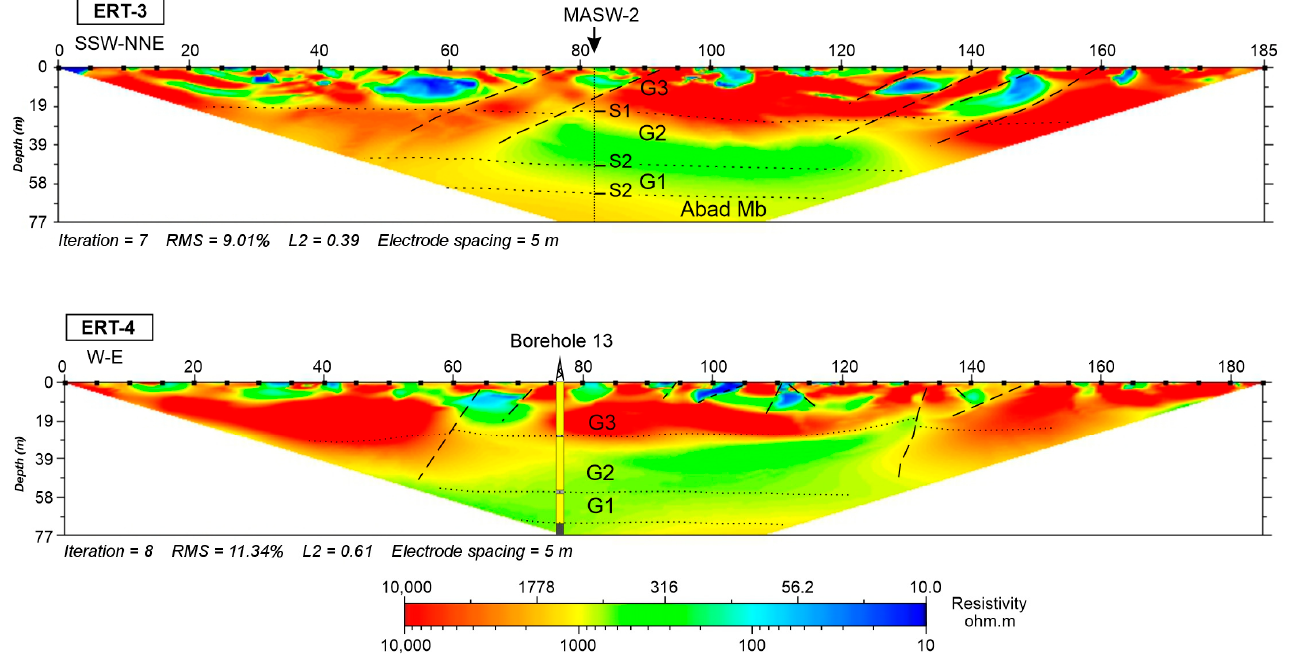
Figure 12. Inverted electrical resistivity tomography data of two perpendicular profiles in the area of borehole 13. The borehole and seismic survey point (MASW-2) are indicated. The upper gypsum bank (G3) has a higher resistivity than the lower banks (G2 and G1).